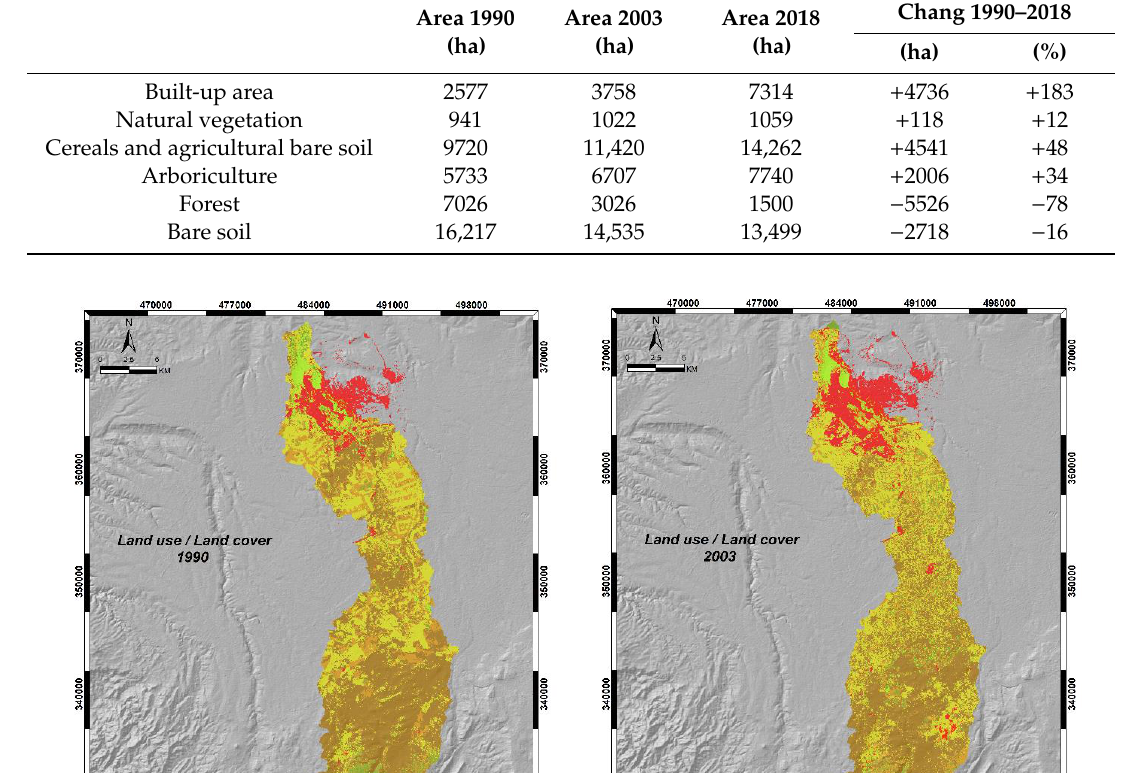
Table 1. Area change in different land use/land cover (LULC) categories from 1990 to 2018.